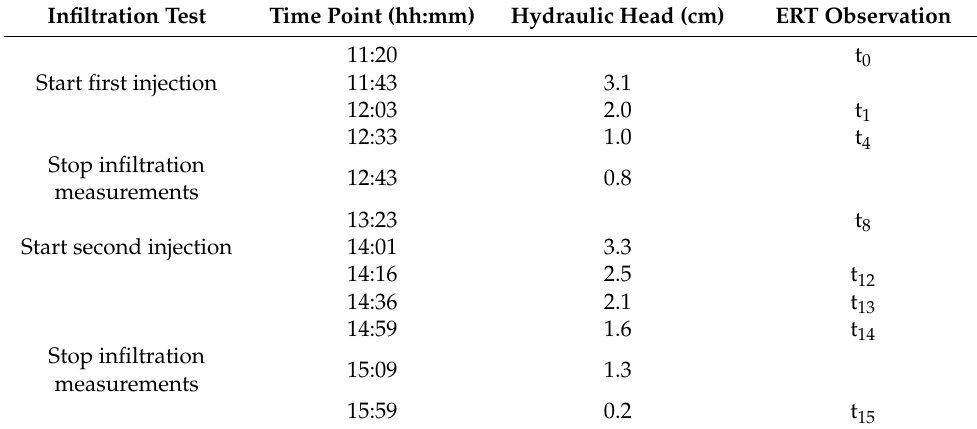
Table 1. Time points of the infiltrometer test and ERT data